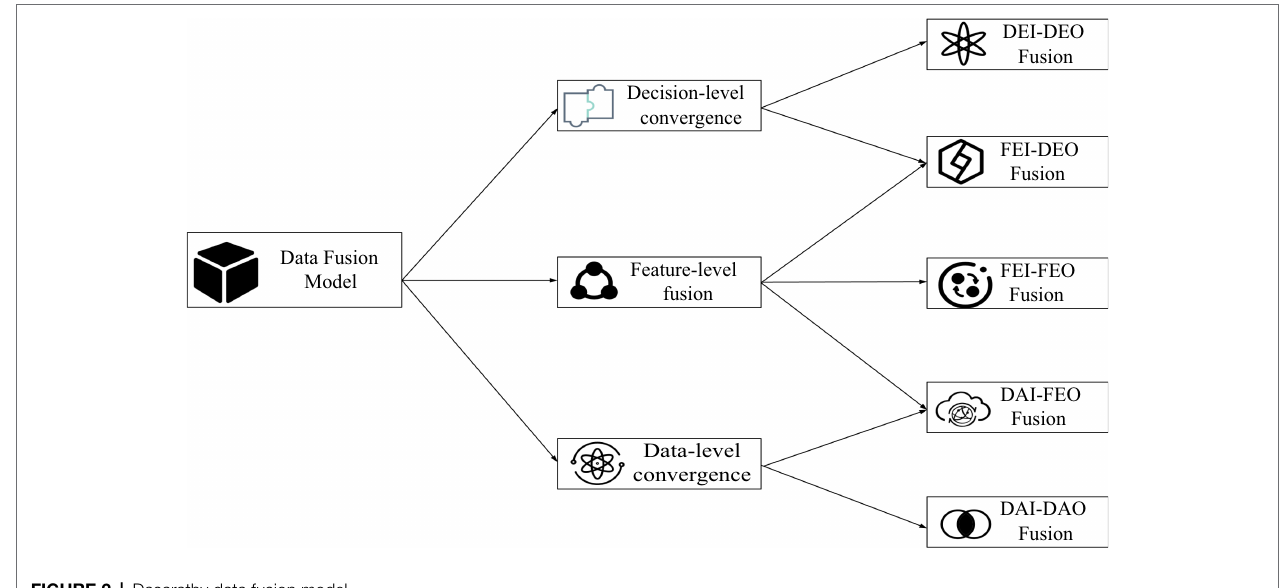
FIGURE 2 | Dasarathy data fusion